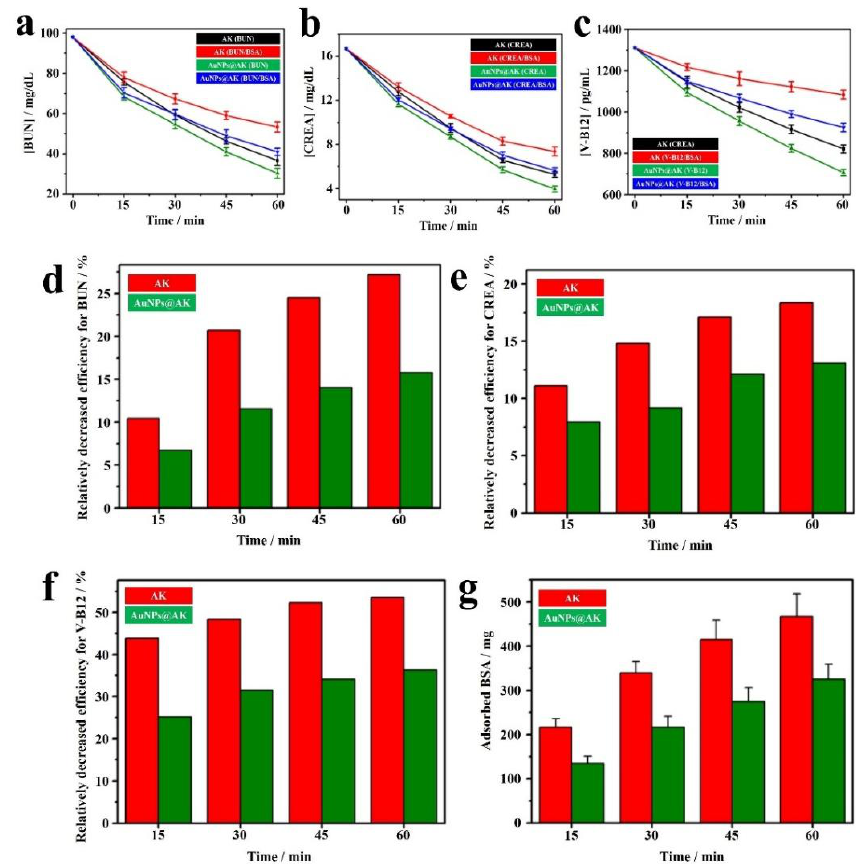
Figure 11. Influence of protein adsorption on the efficiencies of removing uremic toxins for an artificial kidney (AK) and excited AuNPs@AK. Flow rates for injections of the sample and saline solutions were 14 and 20 mL min –1 , respectively. Removal efficiencies of ( a ) BUN; ( b ) CREA; and ( c ) V-B12 in the absence and presence of BSA (4 mg mL –1 ) ( n = 3); The relative removal efficiencies of ( d ) BUN; ( e ) CREA; and ( f ) V-B12 in the absence and presence of BSA (4 mg mL –1 ); ( g ) The amount of adsorbed BSA onto the AK and excited AuNPs@AK during hemodialysis [73].